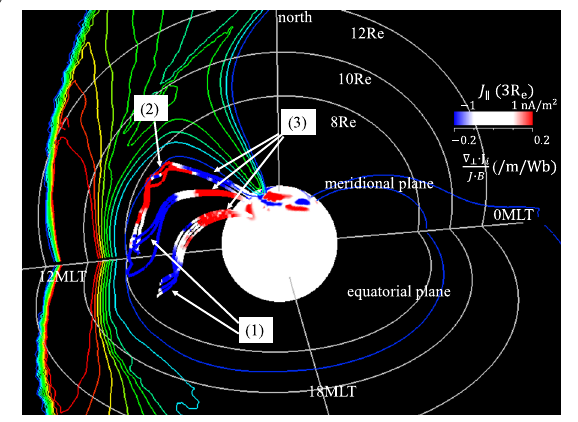
Fig. 13 Type H and L current systems at t 5.5 min colored = according to ∇ ⊥ · J i JB values in the same manner as in Fig. 3. The current lines are shown only in the area of β <0.2. The type L current from A H is not shown in this figure. There are three characteristic regions of the FPC–FAC conversion. The negative and positive ∇ ⊥ · J i JB in regions (1) and (2), respectively, appears in the boundary between the